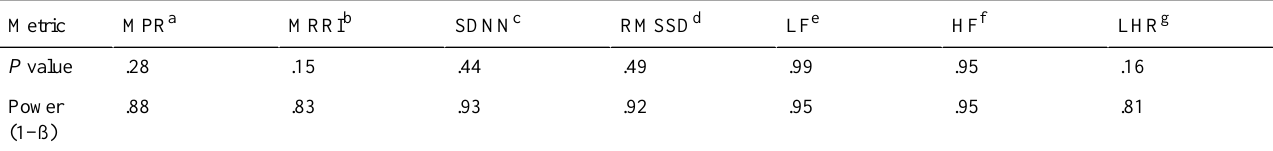
Table 5. Results of secondary analysis including trainees only (Student t